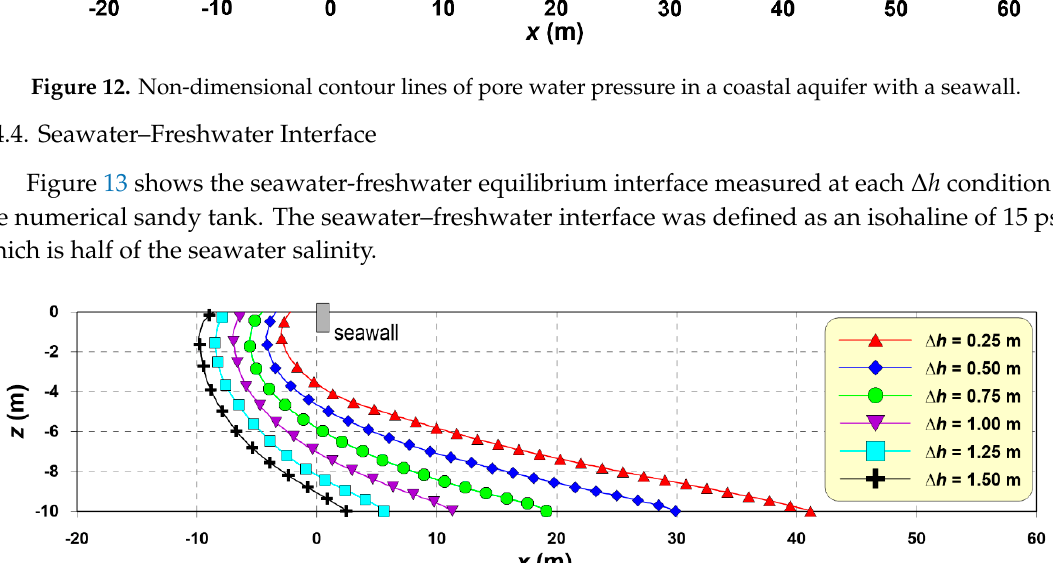
Figure 12. Non-dimensional contour lines of pore water pressure in a coastal aquifer with a seawall.